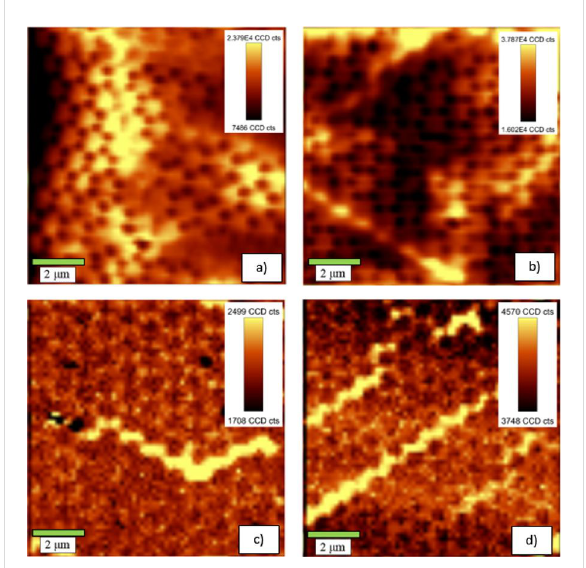
Figure 21: Representative scattering (a, c) and fluorescence (b, d) images of the samples spin coated with VTLUNP nanosuspensions. Areas of high film coverage (a), (b) and low film coverage (c), (d) are depicted.